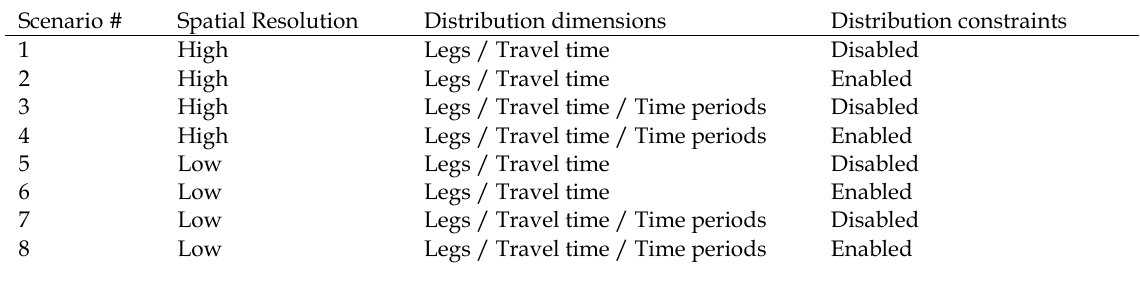
Summary of scenarios’